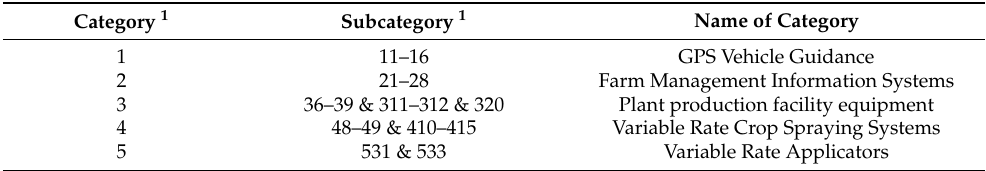
Table 1. Subsidization categories according to the Action 4.1.1 (Implementation of investments that contribute to farm competitiveness) (own